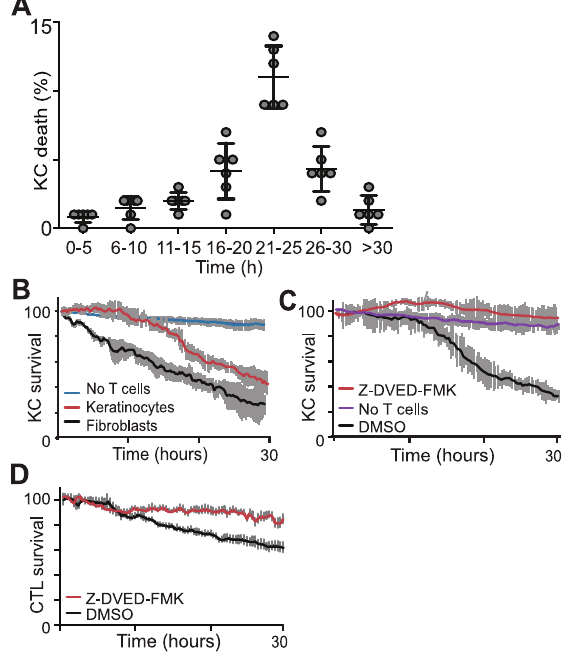
Figure 3. CD8 + T cells require direct prolonged contact with target cells to kill KC. Primary KC loaded with ovalbumin peptide were co-cultured with CD8 + T cells from EGFP + OT-1 mice and imaged over a 30-hour period in the presence of a cell-permeable indicator dye that fluoresces red upon activation of caspase-3. A . The number of caspase-3 positive keratinocytes in each 5 hour time period per experiment was determined by standardized objective analysis of movies by specialized imaging software. N=6, error bars are SEM. B . In